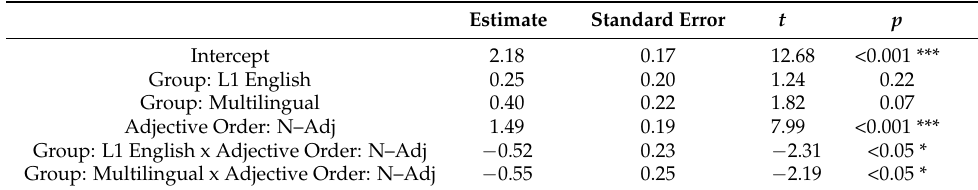
Table 5. Linear model testing the effect of language group and adjective order (*Adj–N/N–Adj) on ac- ceptability judgements (formula: Acceptability Judgement~Group * Adjective Order + (1|Participant) + (1|Item)).